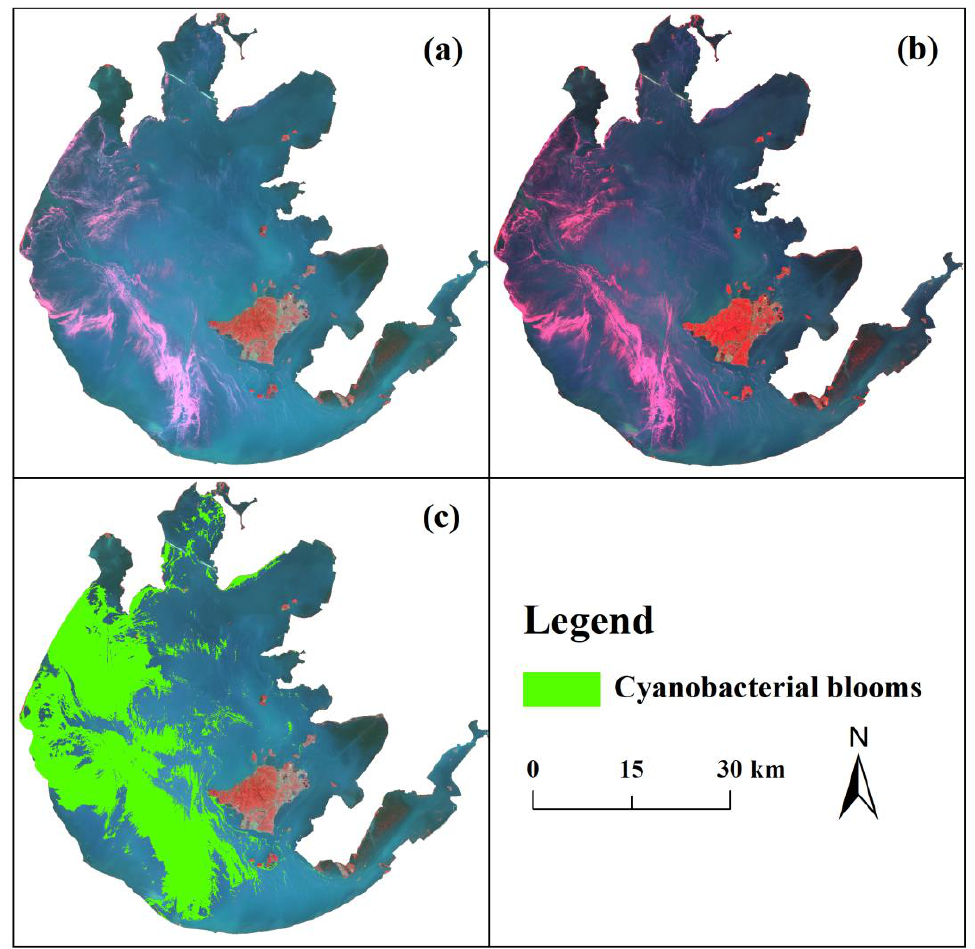
Figure 4. Validation of the cyanobacterial bloom map in Taihu Lake. ( a ) Landsat OLI imagery on 03